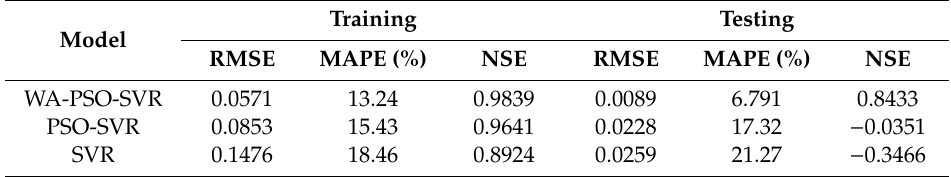
Table 3. Statistical values of daily NH 3 -N prediction in the training and testing phase. Model